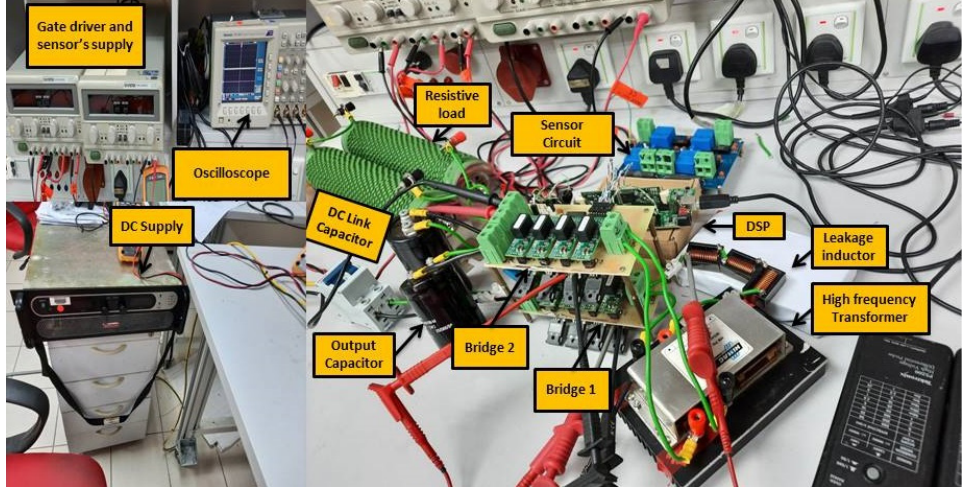
Figure 15. Experimental setup of 300 W DAB–DC/DC converter. Table 3. DAB–DC/DC electrical specifications used for Lab prototype.